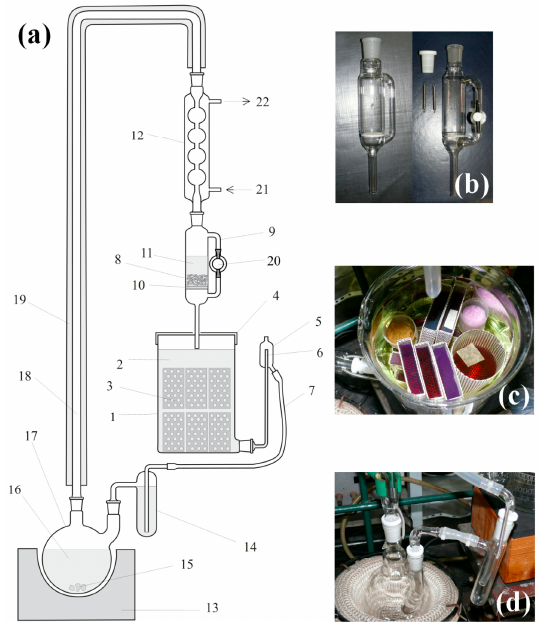
Figure 3. ( a ) Structural drawing of the continuous extractor and solvent regeneration unit, and photographs of ( b ) two types of drying agent holder; ( c ) different kinds of solvogel samples loaded in the extraction chamber; and ( d ) solvent seal. Numbers: (1) extraction chamber, 2 L volume; (2) solvent (acetone); (3) solvogel samples in punched aluminum frames; (4) lid; (5) overflow buffer; (6) solvent level limiter; (7) silicone rubber tubing; (8) anhydrous drying agent Na 2 SO 4 or MgSO 4 ; (9) drying unit with side arm; (10) fritted disc; (11) freshly distilled solvent; (12) condenser; (13) safety electric heater; (14) solvent seal; (15) boiling chips; (16) solvent; (17) two-necked round-bottom flask with ground joints; (18) vapor tube; (19) heat insulation; (20) PTFE stopcock; (21) cooling water in; (22) cooling water out.